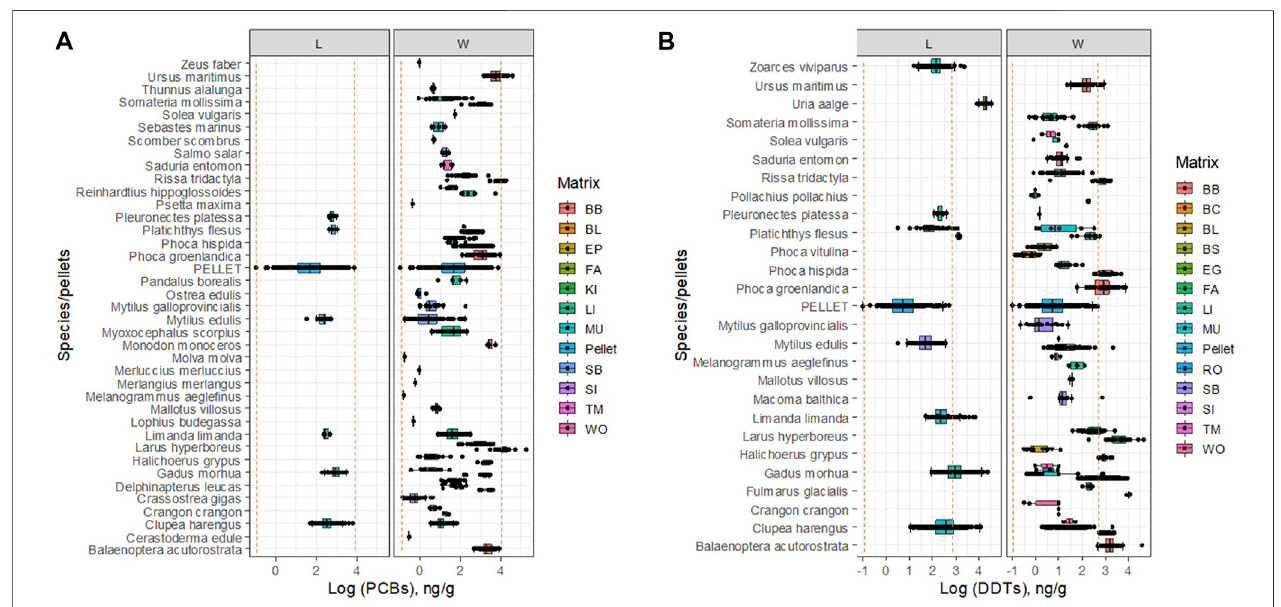
FIGURE 2 | Concentration of PCBs (A) DDTs (B) in marine organisms and marine plastic pellets. L: lipid-normalized; W: wet weight. Vertical lines show a range of concentrations found in.